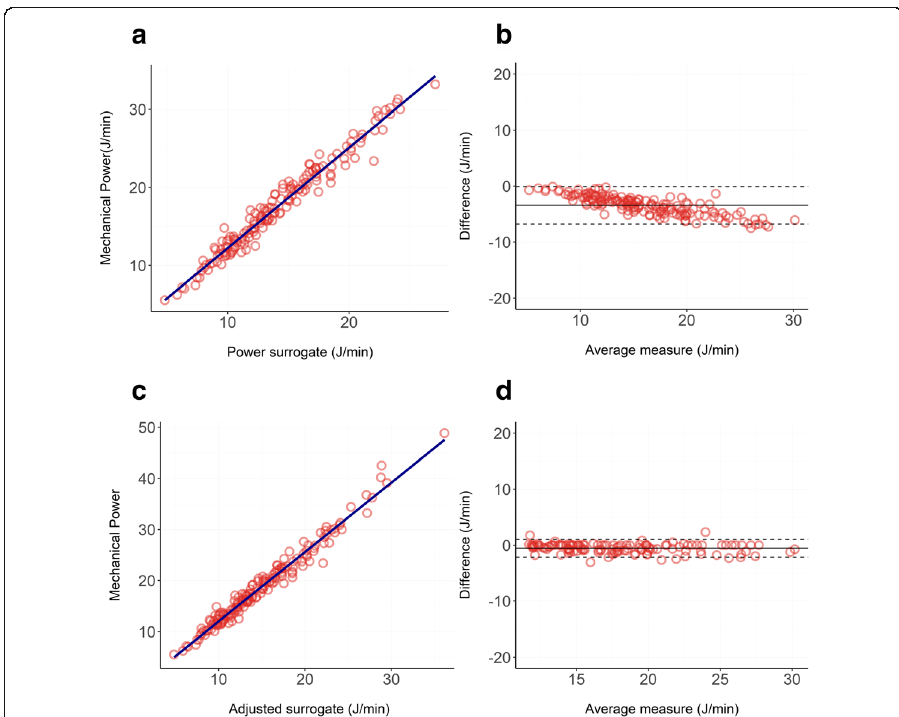
Fig. 4 a , b Relationship between our unadjusted surrogate of mechanical power (Eq. 3) and the reference formula (Eq. 1) in ICU patients treated with 5 cmH 2 O of PEEP: panel a shows the linear regression ( R 2 = 0.96), and panel b shows the Bland-Altman (bias = − 3.43 J/min; proportional error = − 0.27 J/min). c , d Relationship between our adjusted surrogate of mechanical power (Eq. 9) and the reference formula (Eq. 1) in ICU patients treated with 5 cmH 2 O of PEEP: panel c shows the linear regression ( R 2 = 0.98), and panel d shows the Bland-Altman (bias = − 0.53 J/min; proportional error = − 0.03